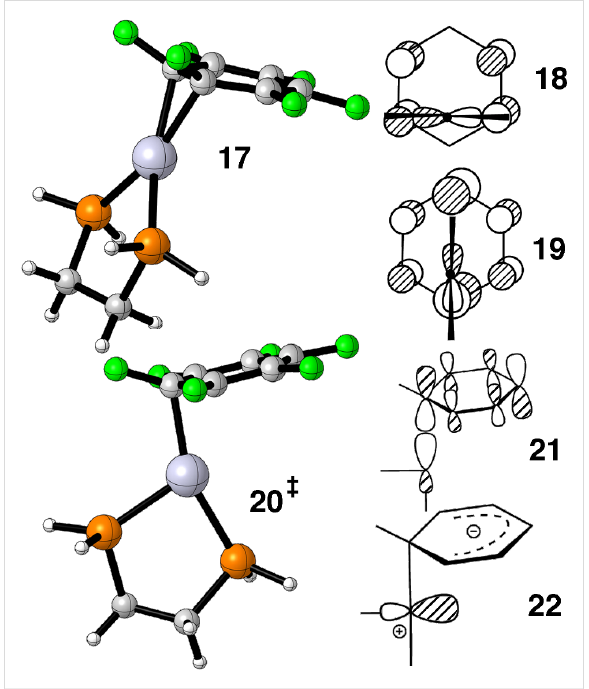
respect to the Cp ring is approximately that given by 13 . Ac-